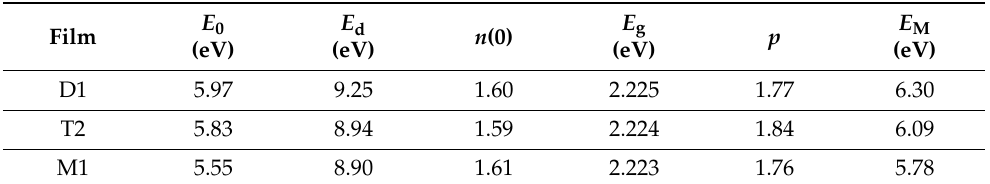
Table 2. Values of parameters of the PAZO polymer films, included in the DMs only for n ( λ ) or k ( λ ), calculated from Equation (2)–(6).